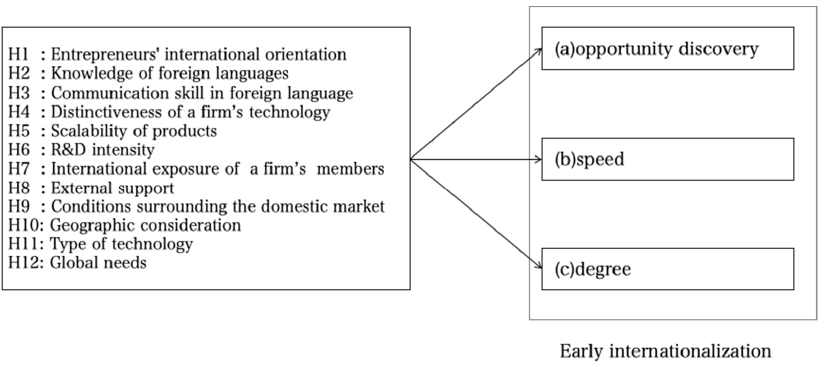
Figure 1. Conceptual